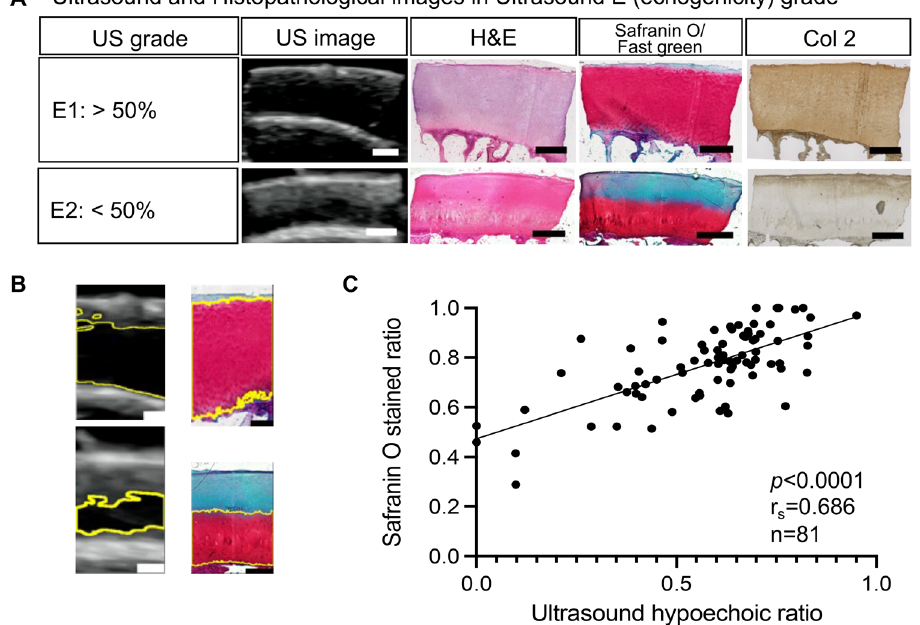
Figure 2. Ultrasound E (cartilage echogenicity) grade and proteoglycan localization in articular cartilage. ( A ) Ultrasound images of typical cases. Scale bars: 1 mm. ( B ) Comparison of ultrasound hypoechoic area and safranin O-stained regions of the central third of images. Scale bars: 1 mm. ( C ) Spearman’s correlation graph between ultrasound hypoechoic ratio and safranin O-stained ratio in histology. Spearman’s correlation coefficient (r s ) was